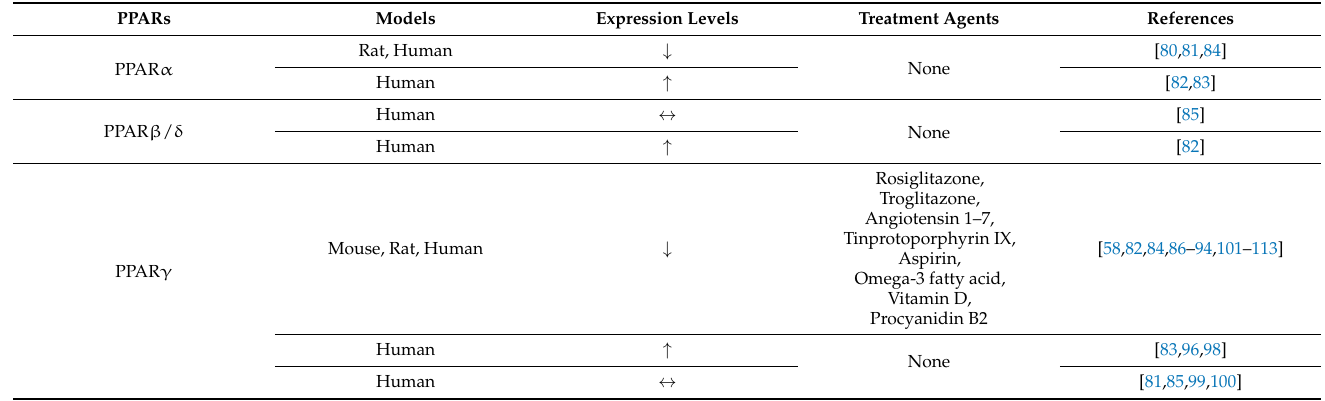
Table 2. The role of PPARs in